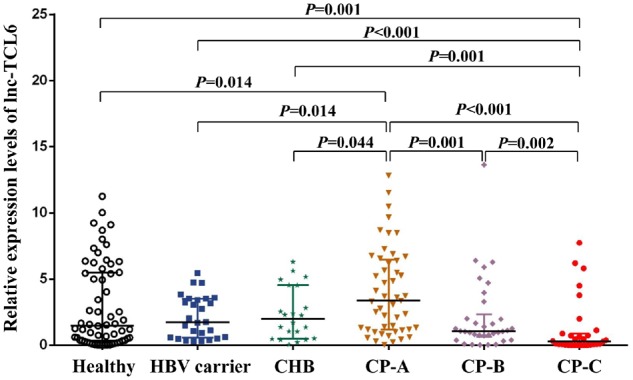
Differential expression levels of lnc-TCL6 in the three different clinical stages of liver cirrhosis (LC). Compared with the healthy controls, HBV carriers, and chronic hepatitis B (CHB) patients, the expression of lnc-TCL6 in Child–Pugh A (CP-A) cirrhosis was significantly elevated but gradually decreased through CP-B to CP-C cirrhosis. There was a minimum expression of lnc-TCL6 in the CP-C cirrhosis group compared with the other five groups. Data are presented as median with interquartile range.